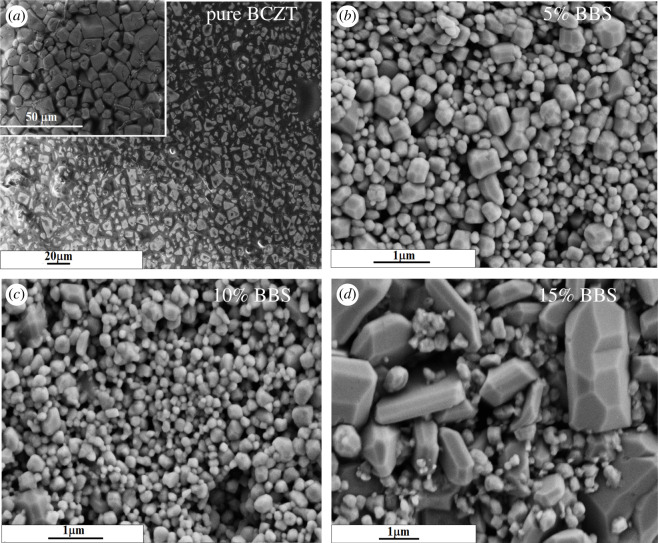
(a–d) SEM images of (1 − x)BCZT-xBBS (x = 0, 0.05, 0.1, 0.15) glass ceramics.